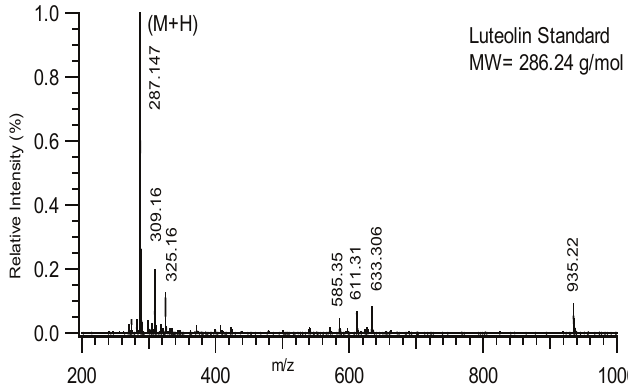
FIGURE 3 - MALDI-TOF spectrum of Luteolin